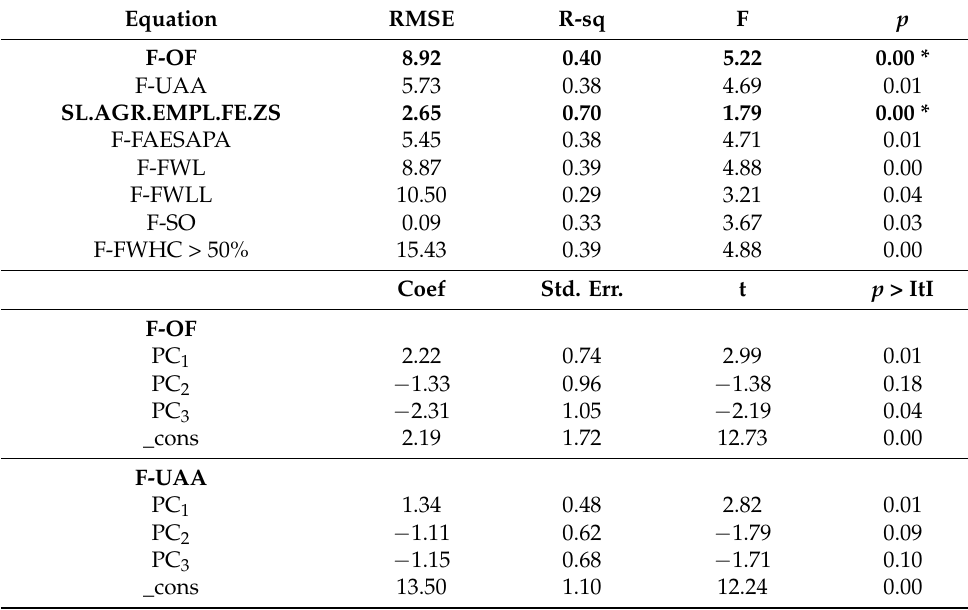
Table 8. Estimate of coefficients of the multivariate regression